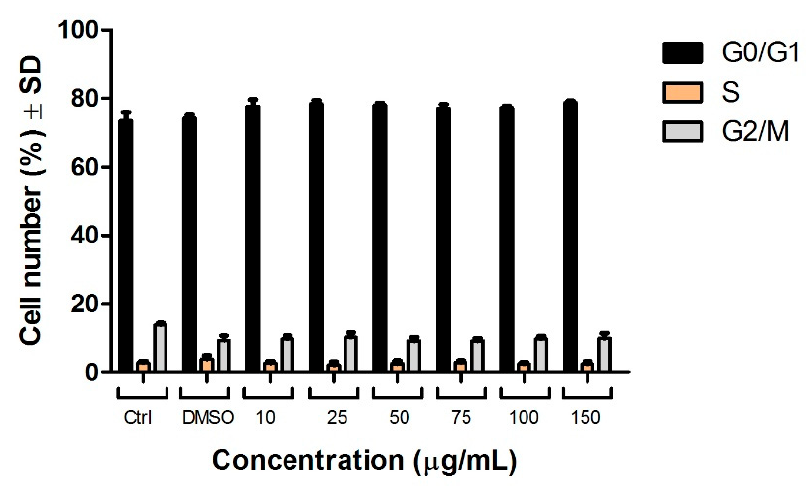
Figure 5. A549 human lung adenocarcinoma cell cycle analysis after stimulation with Pg extract (10, 25, 50, 75, 100, and 150 µg/mL) on G0/G1; S and G2/M phases. The results are expressed as cell number percentage (%) ± standard deviation.